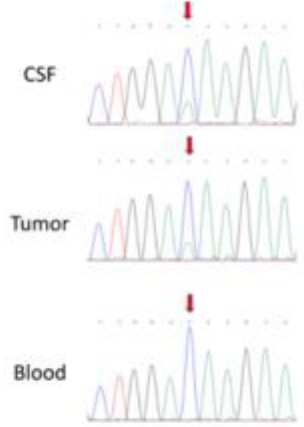
Figure 4. NRAS Q61K mutation was detected by Sanger sequencing performed on DNA extracted from both tumor sample and CSF neoplastic cells. NRAS Q61K is a hotspot mutation located in the GTP-binding region of the NRAS protein, conferring a loss of function as indicated by activation of downstream pathway signaling, increased survival, and transformation of cultured cells.